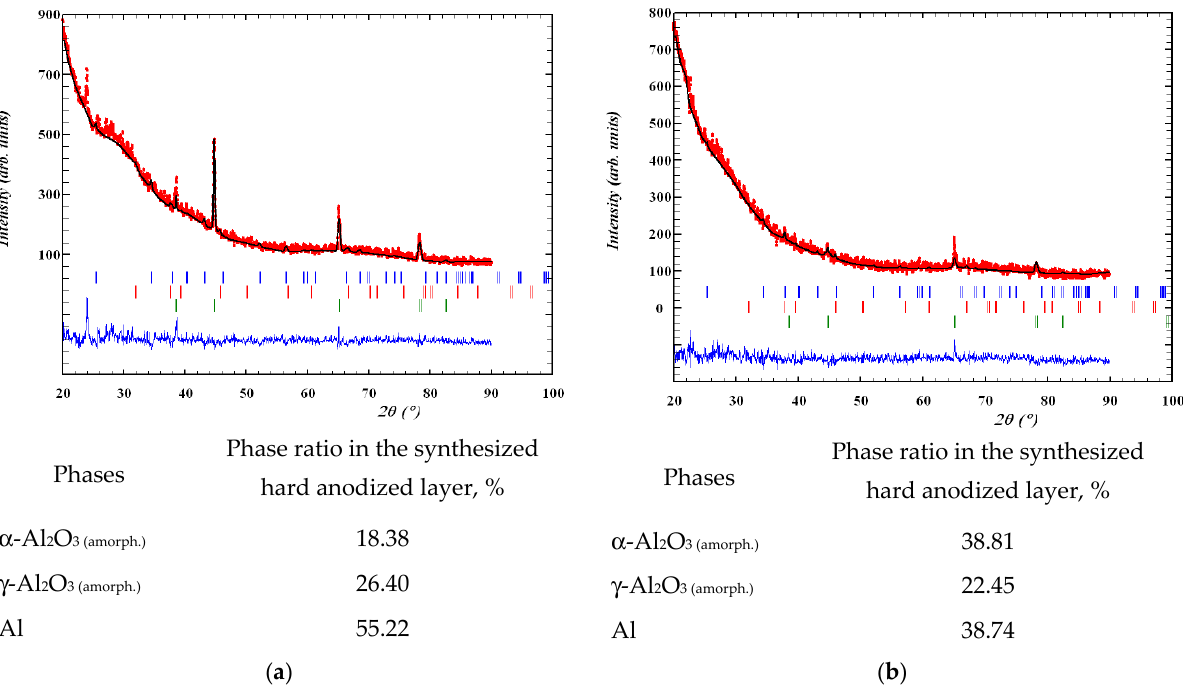
Figure 10. X-ray diffraction patterns and phase ratios in hard-anodized layers synthesized ( a ) for 2 and ( b ) 3 h on specimens of aluminum alloy 1011 followed by their heat treatment at 300 °C for 1 h.